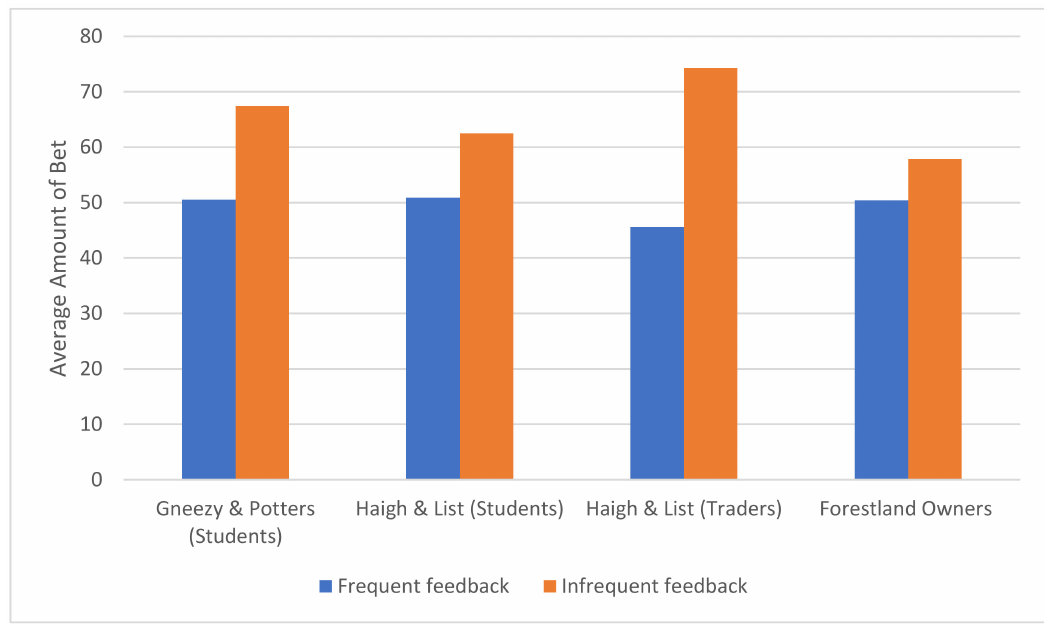
Figure 1. Comparing betting